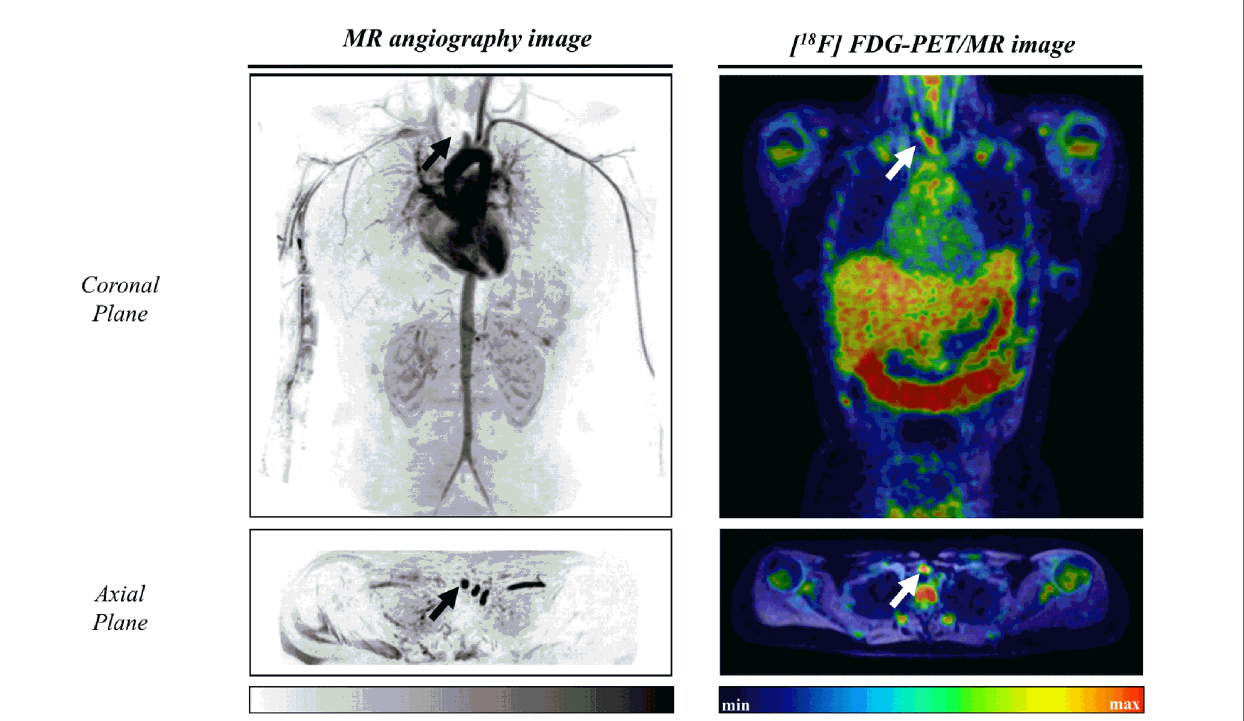
FIGURE 2 | Illustrative case of a 17-year-old female patient with childhood-onset Takayasu Arteritis. Left: Angioresonance of aorta and its branches after intravenous administration of gadolinium. Arrows indicates an occlusion at the third portion of the brachiocephalic trunk. Right: Arterial in fl ammation grade III as assessed by 18 F- fl uorodeoxyglucose-positron emission tomography/magnetic resonance image at the brachiocephalic trunk (SUV max